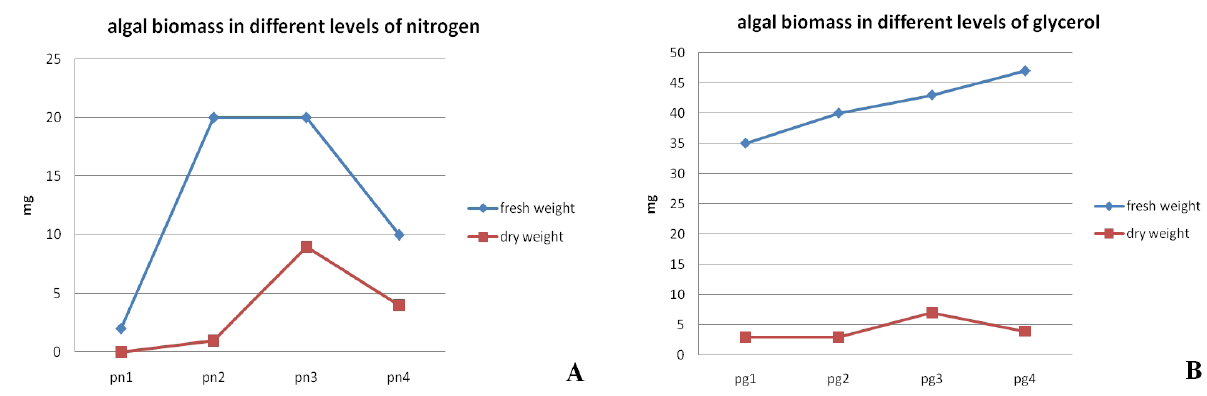
Fig. 6. Fresh weight and dry weight of S. dimorphus in Proteose medium with different levels of nitrogen (A) and glycerol